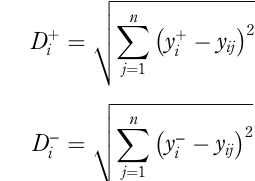
ffiffiffiffiffiffiffiffiffiffiffiffiffiffiffiffiffiffiffiffiffiffiffiffiffiffiffiffi X n